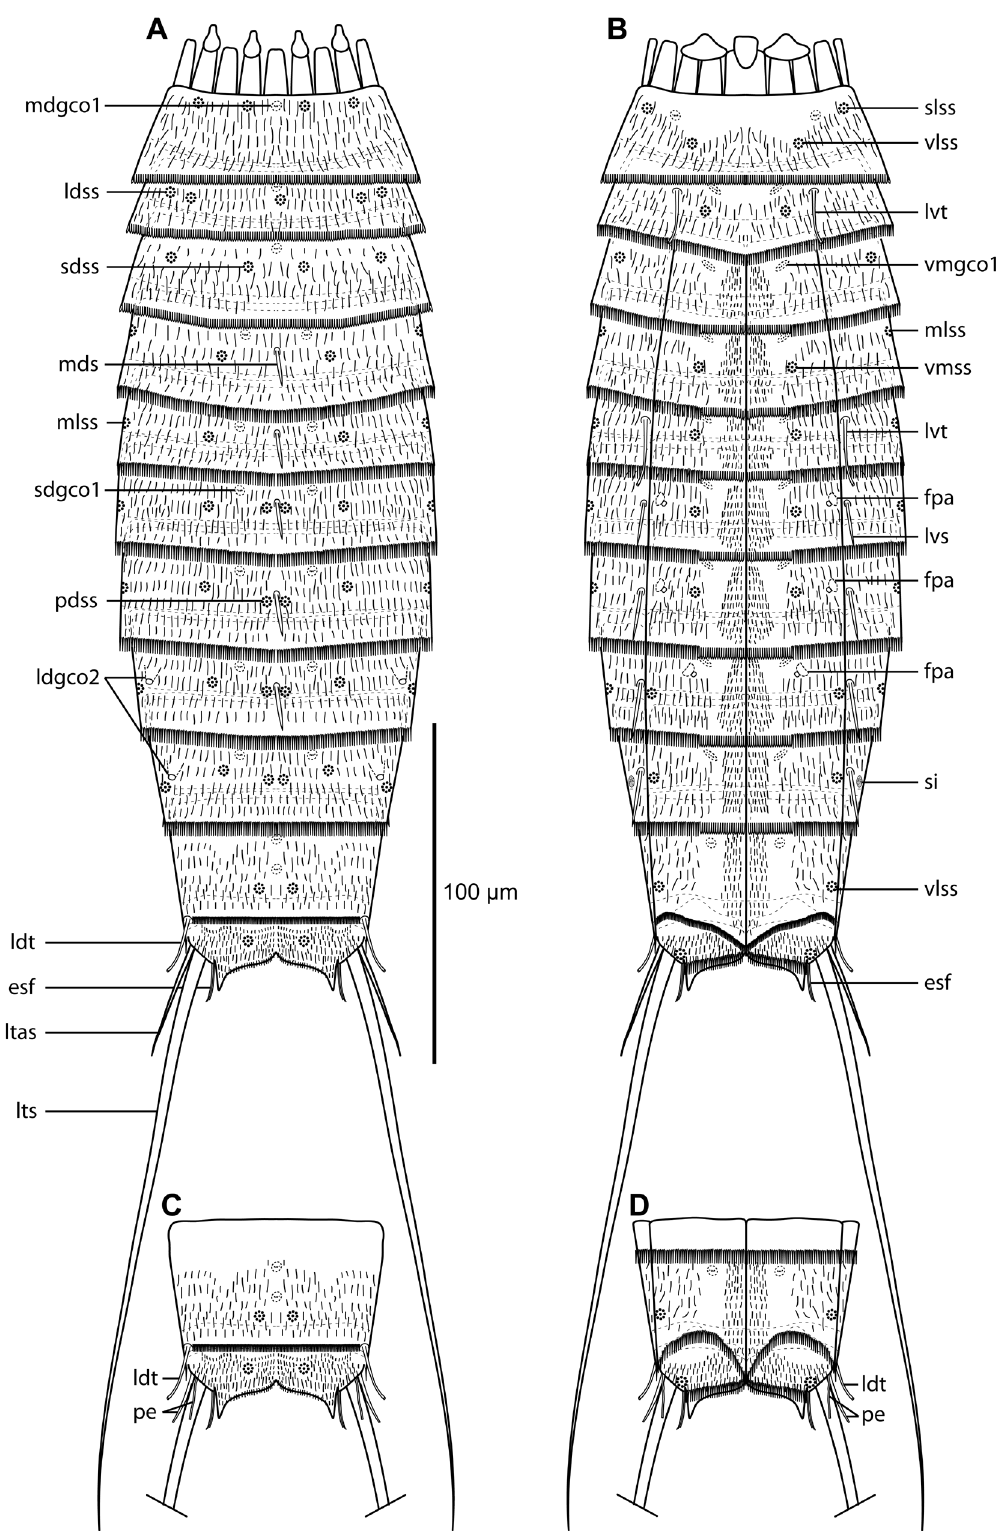
Fig. 22. Line art illustrations of Echinoderes chandrasekharai Sørensen & Chatterjee sp. nov. A . Female, dorsal view. B . Female, ventral view. C . Segments 10 to 11 in male, dorsal view. D . Segments 10 to 11 in male, ventral